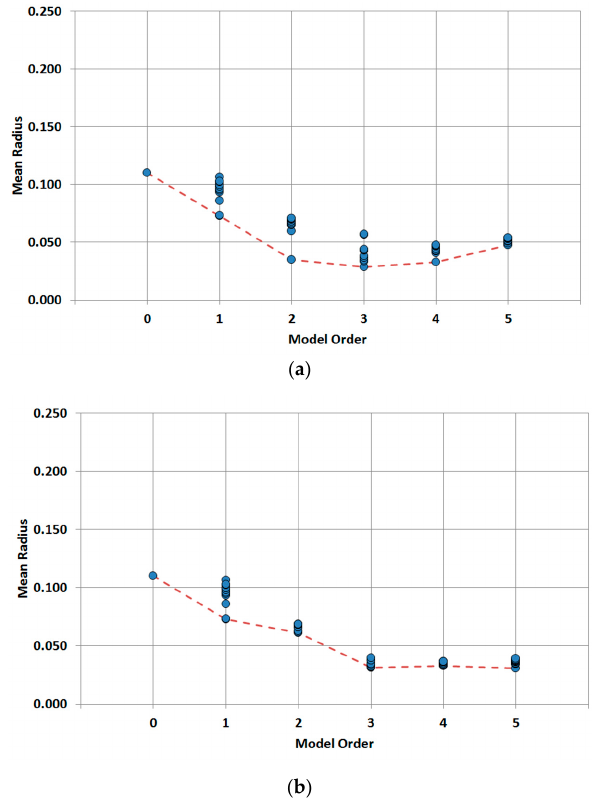
Figure 9. Trunk mains: Mean Radius vs. Model order. Blue dots represent values obtained for individual models and the dashed red line represents the best models: ( a ) independent variables; and ( b ) two joint variables plus additional independent variables. Table 6. Best predictive models: Trunk mains. Values in parenthesis represent the number of intervals considered in variable discretization (F stands for full resolution).